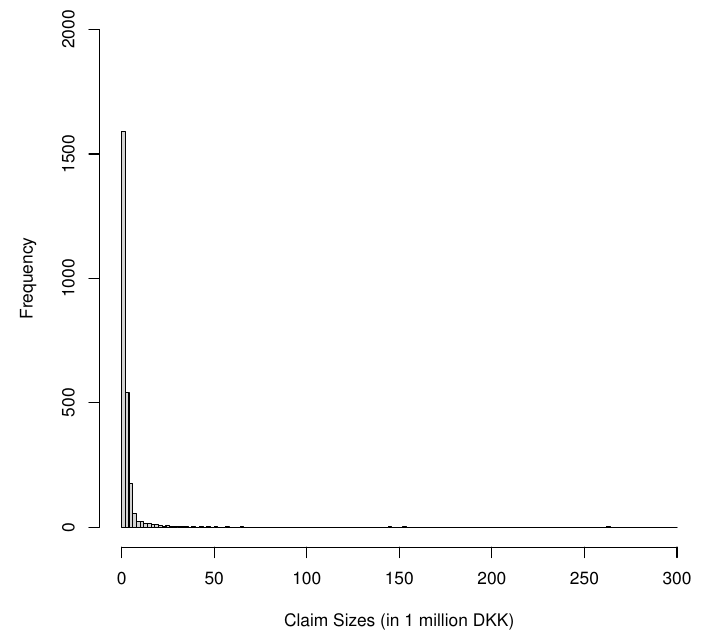
Figure 3. Histogram of Danish fire insurance dataset.